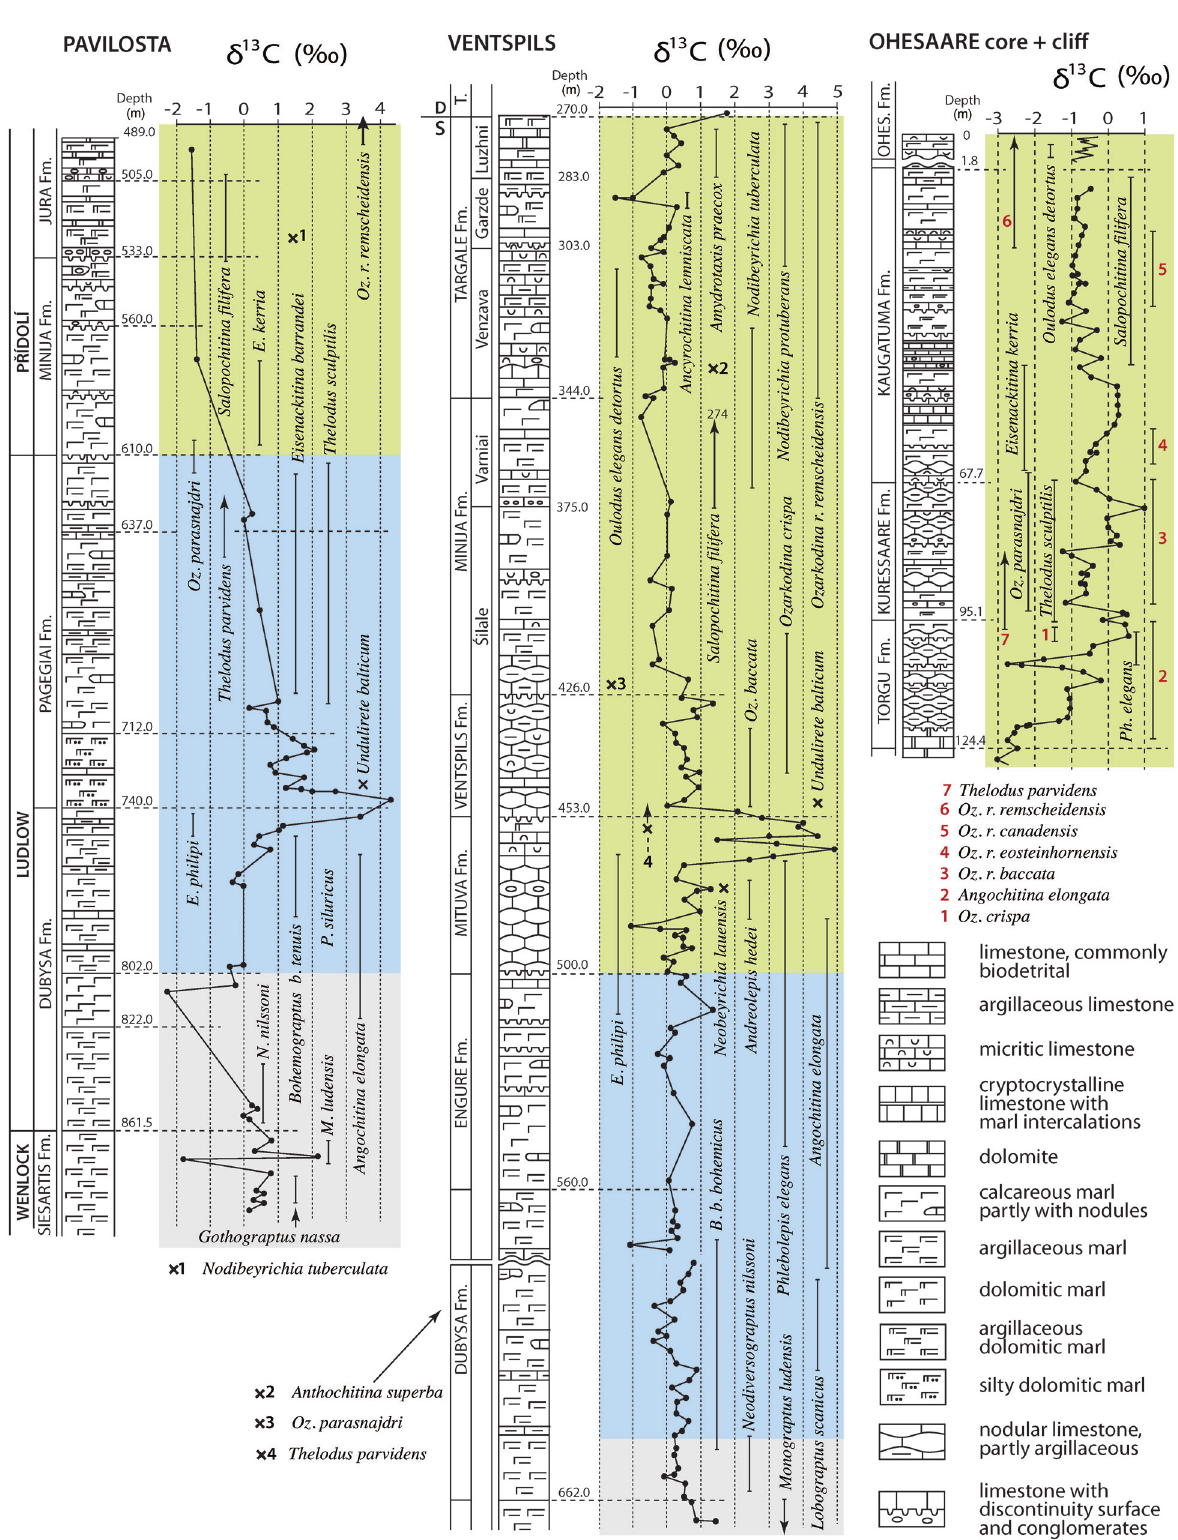
Fig. 2. Lithological logs, stratigraphy, facies interpretation, δ 13 C trend and a selection of ranges of fossils dating certain strati- graphical levels in the Pavilosta, Ventspils and Ohesaare core and cliff sections. Background colours denote general facies situation as follows: green – carbonate shelf; blue – outer shelf; grey – intracratonic